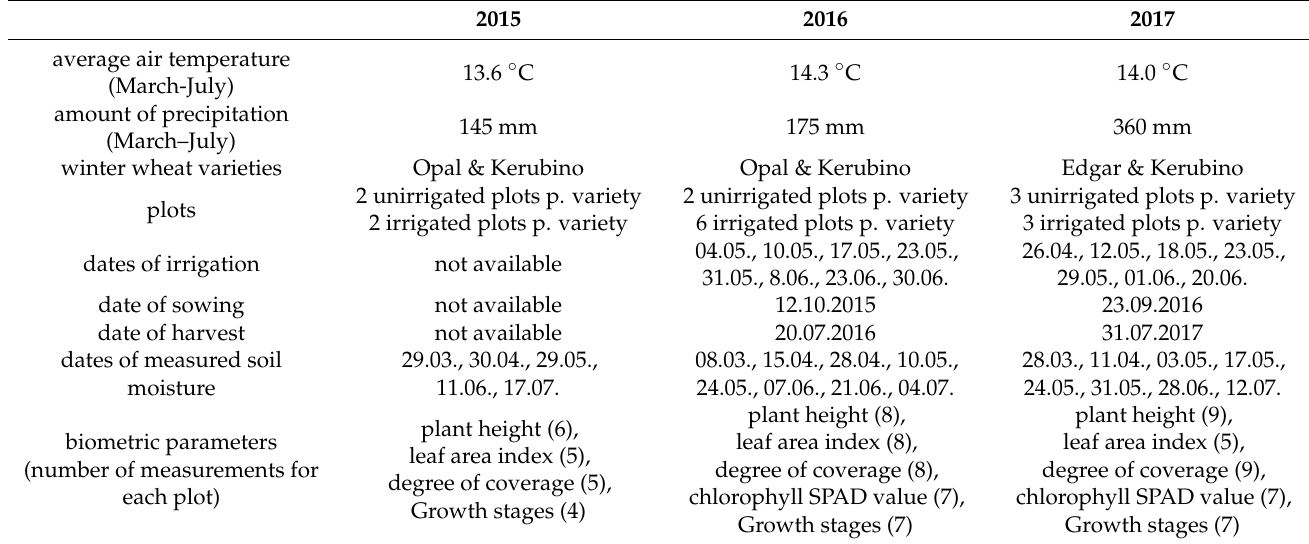
Table 1. Detailed data on the field